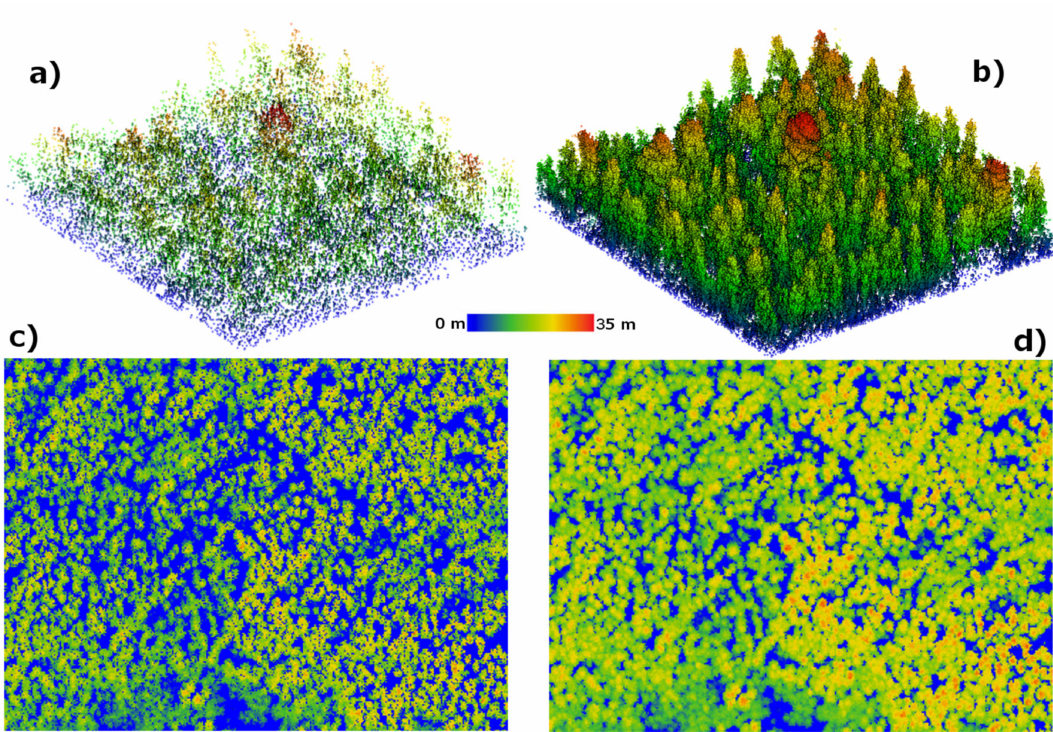
Figure 7. Point cloud calculated (100 m × 100 m) using ( a ) lower-density single acquisition and ( b ) a high-density multi-temporal point cloud after co-registration. The canopy height models (1 m resolution, 350 m × 250 m) have been calculated using ( c ) one and ( d ) 12 lidar